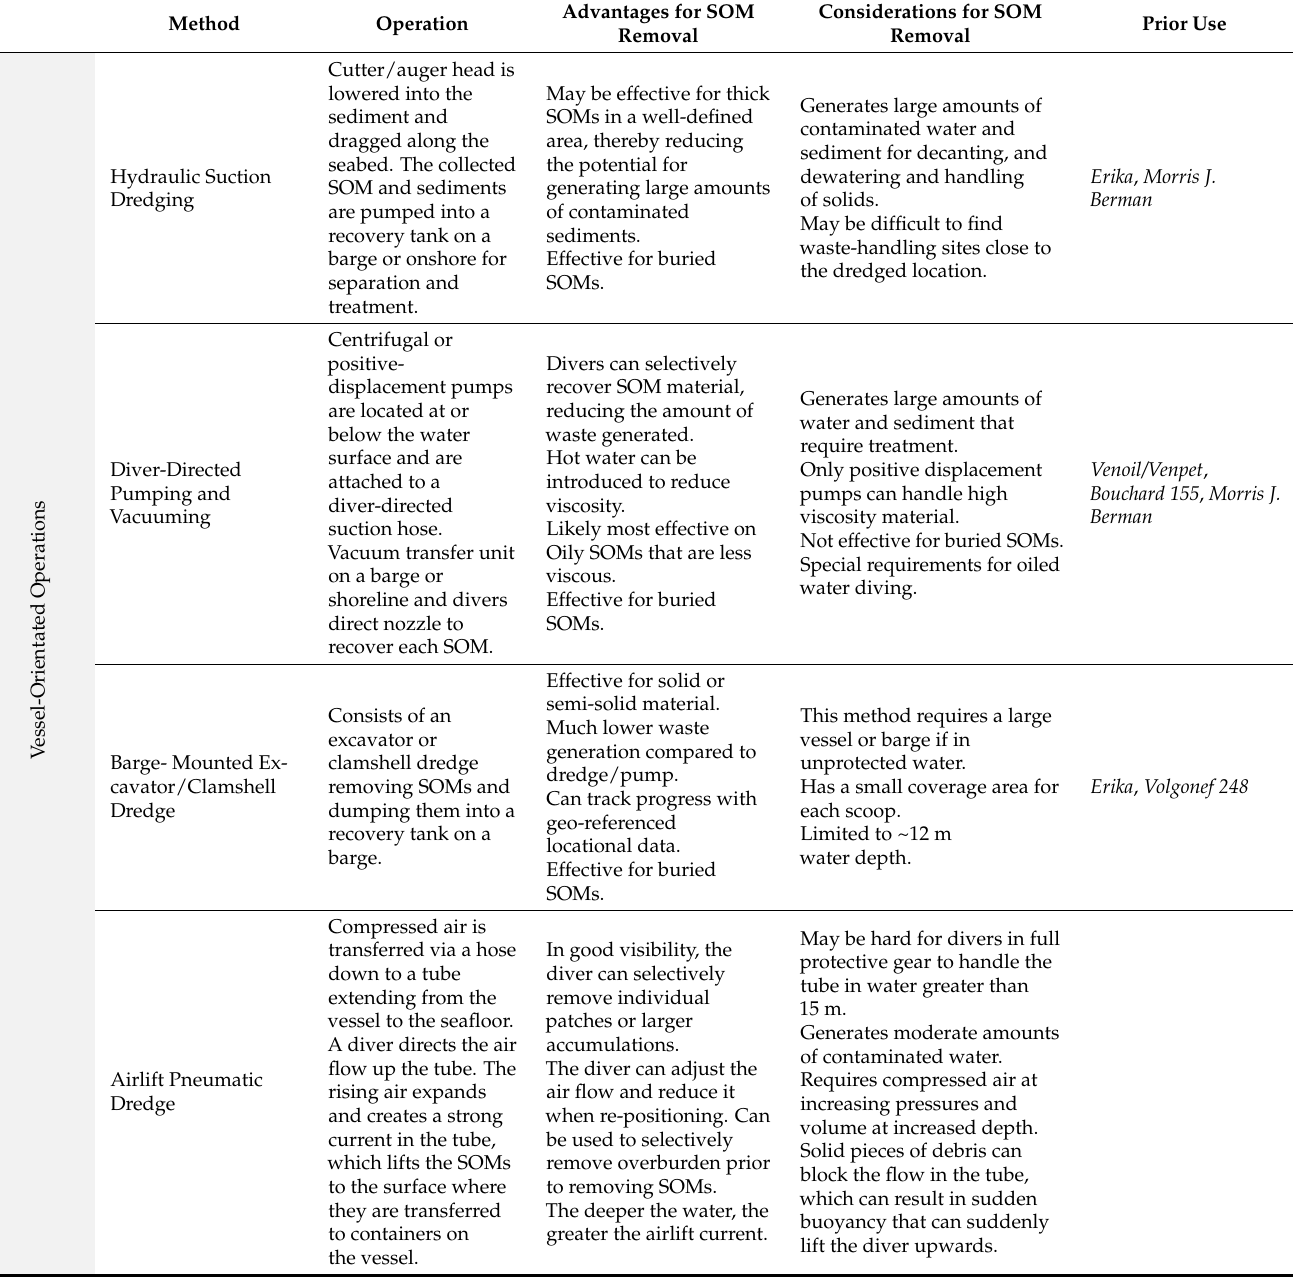
Table 6. SOM removal using vessel-oriented methods for open-water environments seaward of the surf